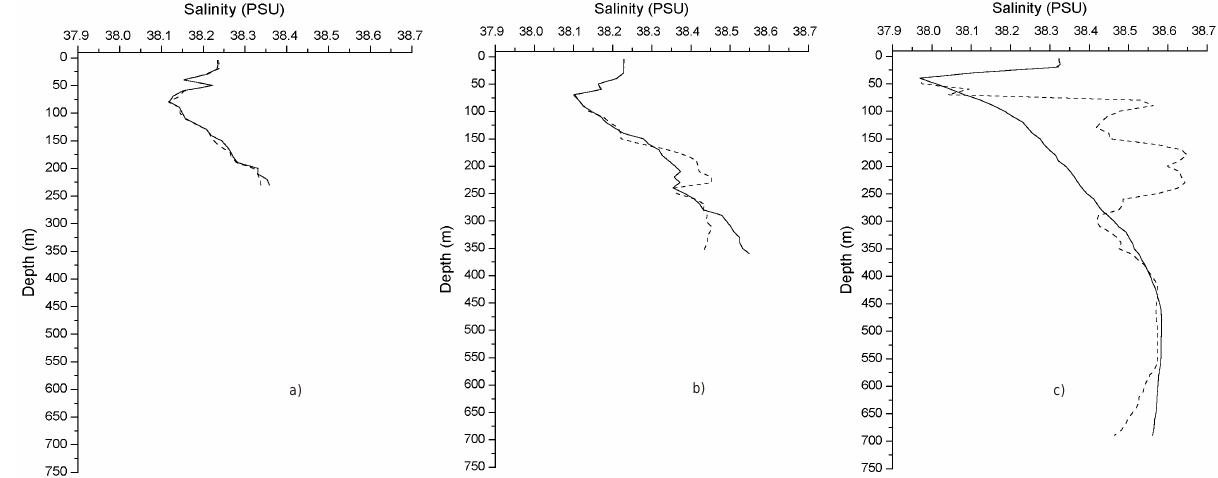
Fig. 2. Comparison between synthetic (dashed line) and CTD-measured (solid line) salinities (best estimate (a) , satisfactory estimate (b) and worst estimate (c) ) during September